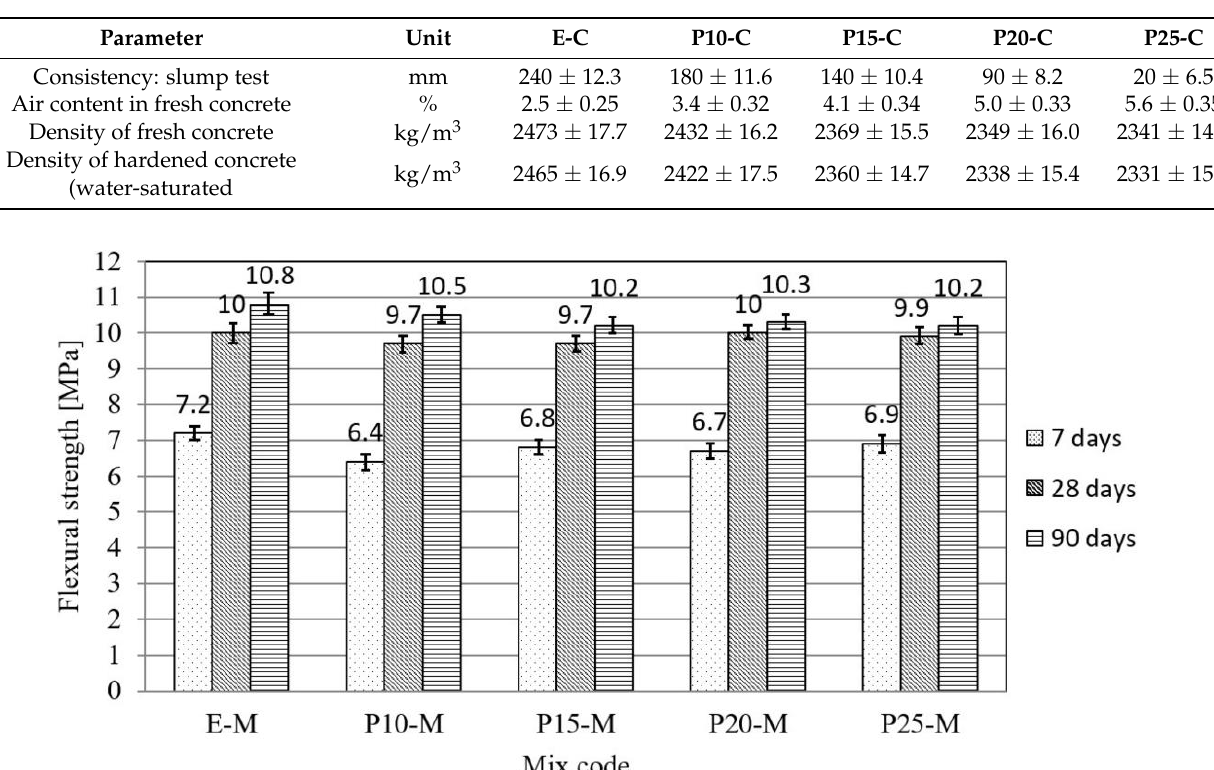
Figure 2. Compressive strength of mortar mixtures. The flexural and compressive strength tests were performed at the mortar specimen age of 7, 28, and 90 days (Figures 1 and 2). Based on the test results, it can be observed that with the increasing cement replacement by waste material, the strength of mortar specimens decreased at an early age (7 days). On the other hand, with increasing age (28 and 90 days) the strength of mortar with the waste material approached the values of the reference mortar. This is attributed to the pozzolanic reaction of slag and silica fumes, which manifested itself at a later stage of hardening [17–20]. That is the reason that the percentage of possible replacement of cement with waste material was estimated based on strength at 90 days. The decrease in compressive strength was from 7.0% up to 19.2% with a percentage replacement of cement from 10 to 25%. One of the reasons for the